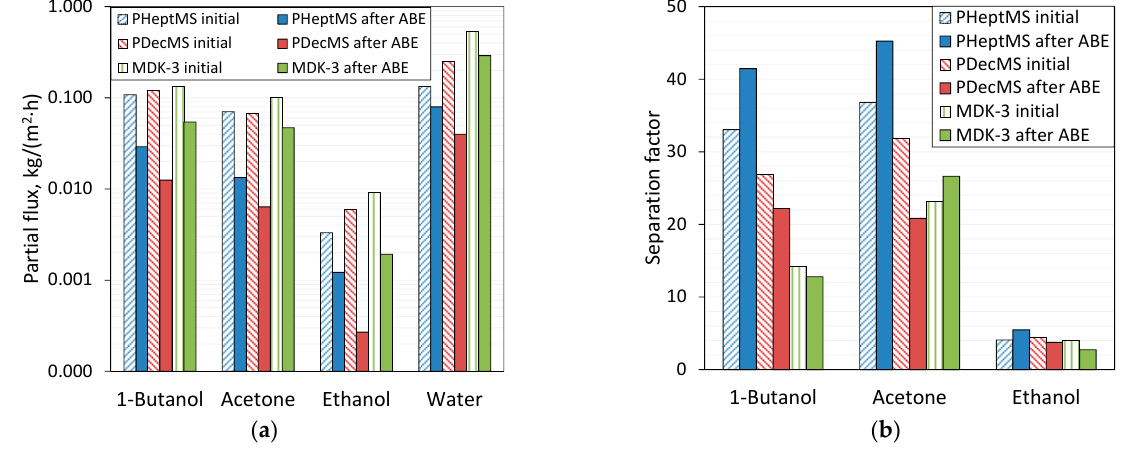
Figure 8. Comparison of partial fluxes ( a ) and separation factors ( b ) at 30 ◦ C of PHeptMS, PDecMS, and MDK-3 membranes before and after membrane contact with ABE-fermentation broth.